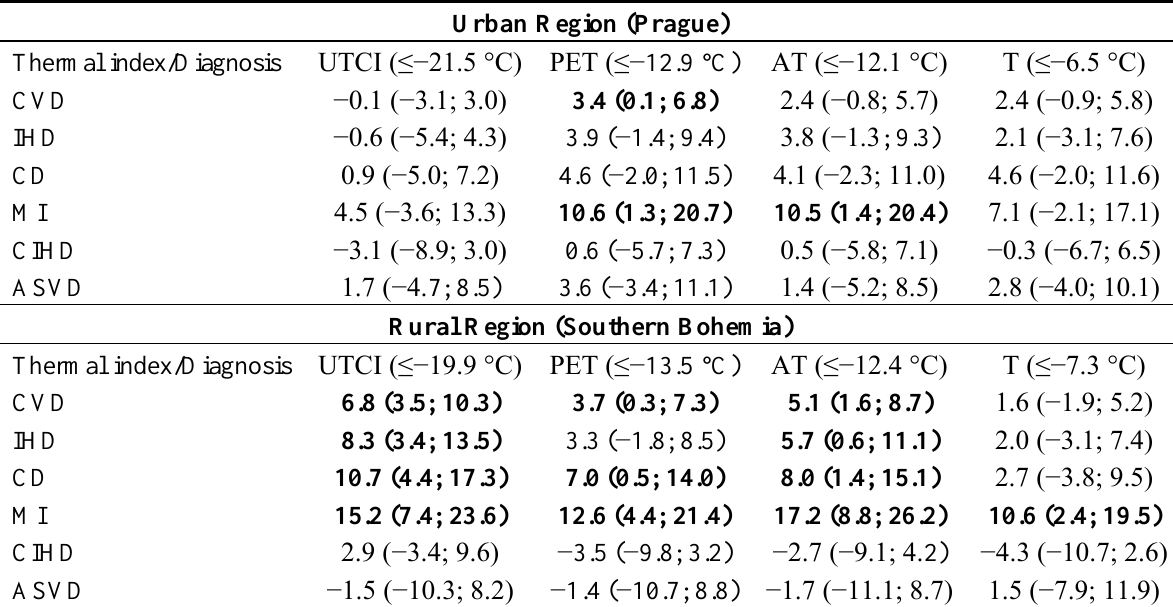
Table 5. Relative excess cardiovascular mortality with 95% CI (in parentheses) on cold days, defined as days with average (equivalent) temperature above the 90% quantile of the empirical distribution (≤°C), in Prague and southern Bohemia over 1994–2009. Values significantly different from zero are highlighted in